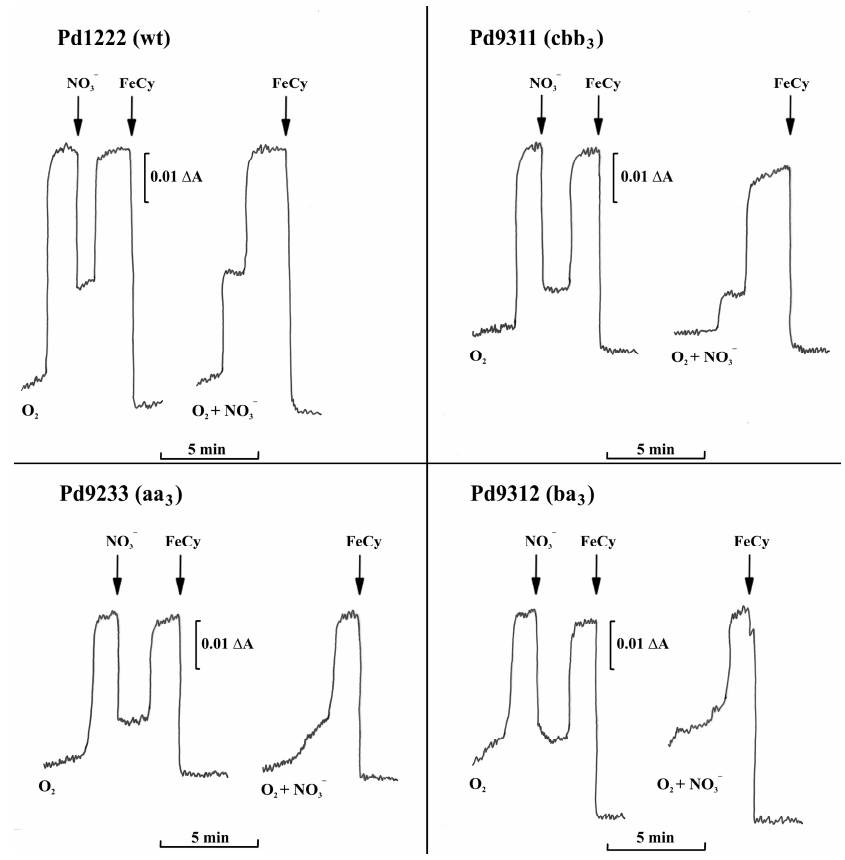
Figure 5. Electron acceptor-induced transient oxidation of cytochromes c . A closed 1-cm cuvette contained 3 mL of 5 mM succinate in 0.1 M sodium phosphate buffer (pH 7.3, 30 °C). At zero time, 9.3 mg dry weight of anaerobically grown cells were added and the time course of cytochrome c reduction was measured by dual wavelength spectroscopy at the wavelength pair 550 minus 535 nm. 0.24 mM O 2 and/or 0.17 mM nitrate were present initially or at the times indicated by arrows. FeCy stands for potassium ferricyanide, added to attain the fully oxidized level.